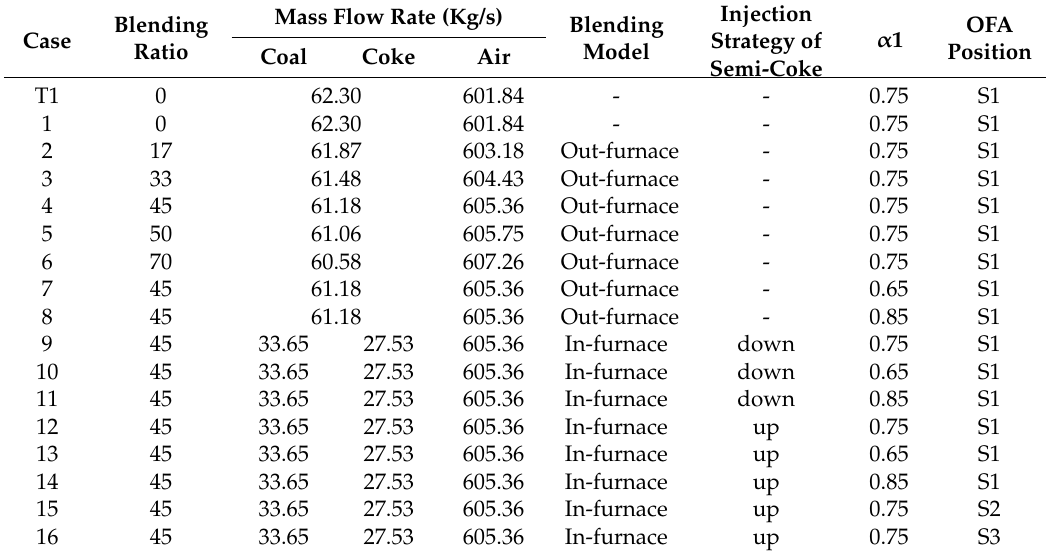
Table 2. Detailed operation conditions of simulation cases.